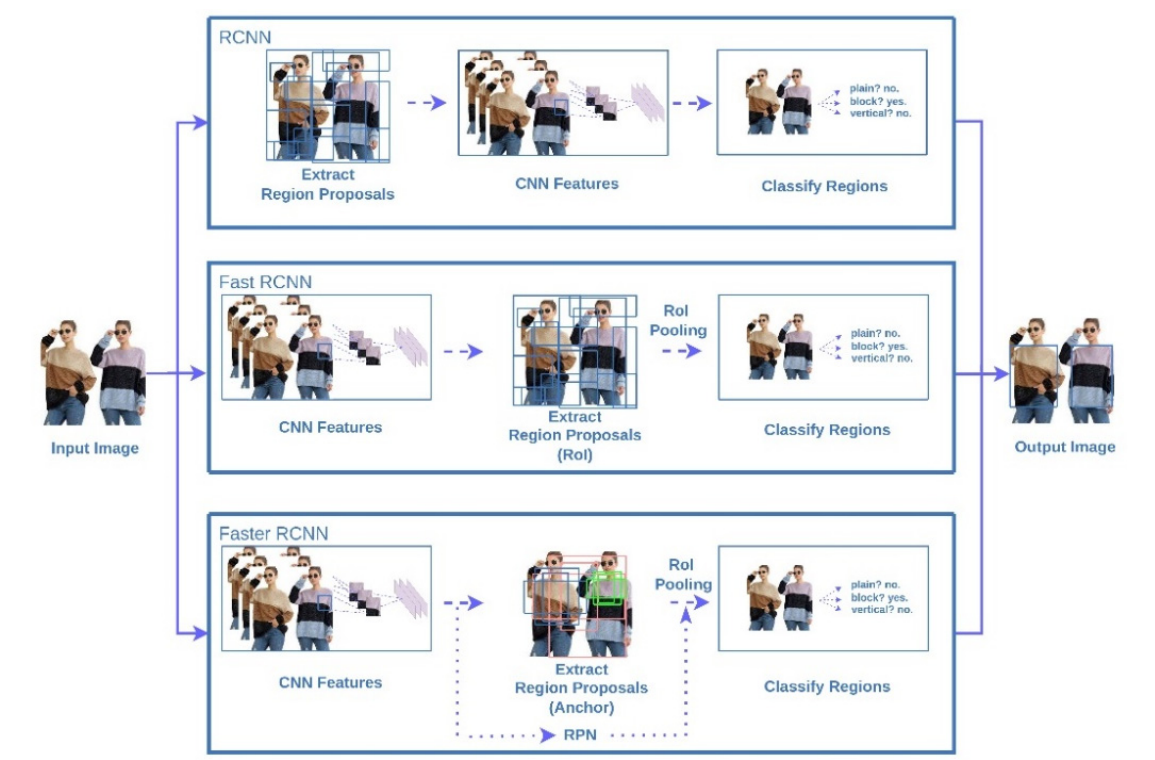
Figure 1. Two-stage object detection algorithms.